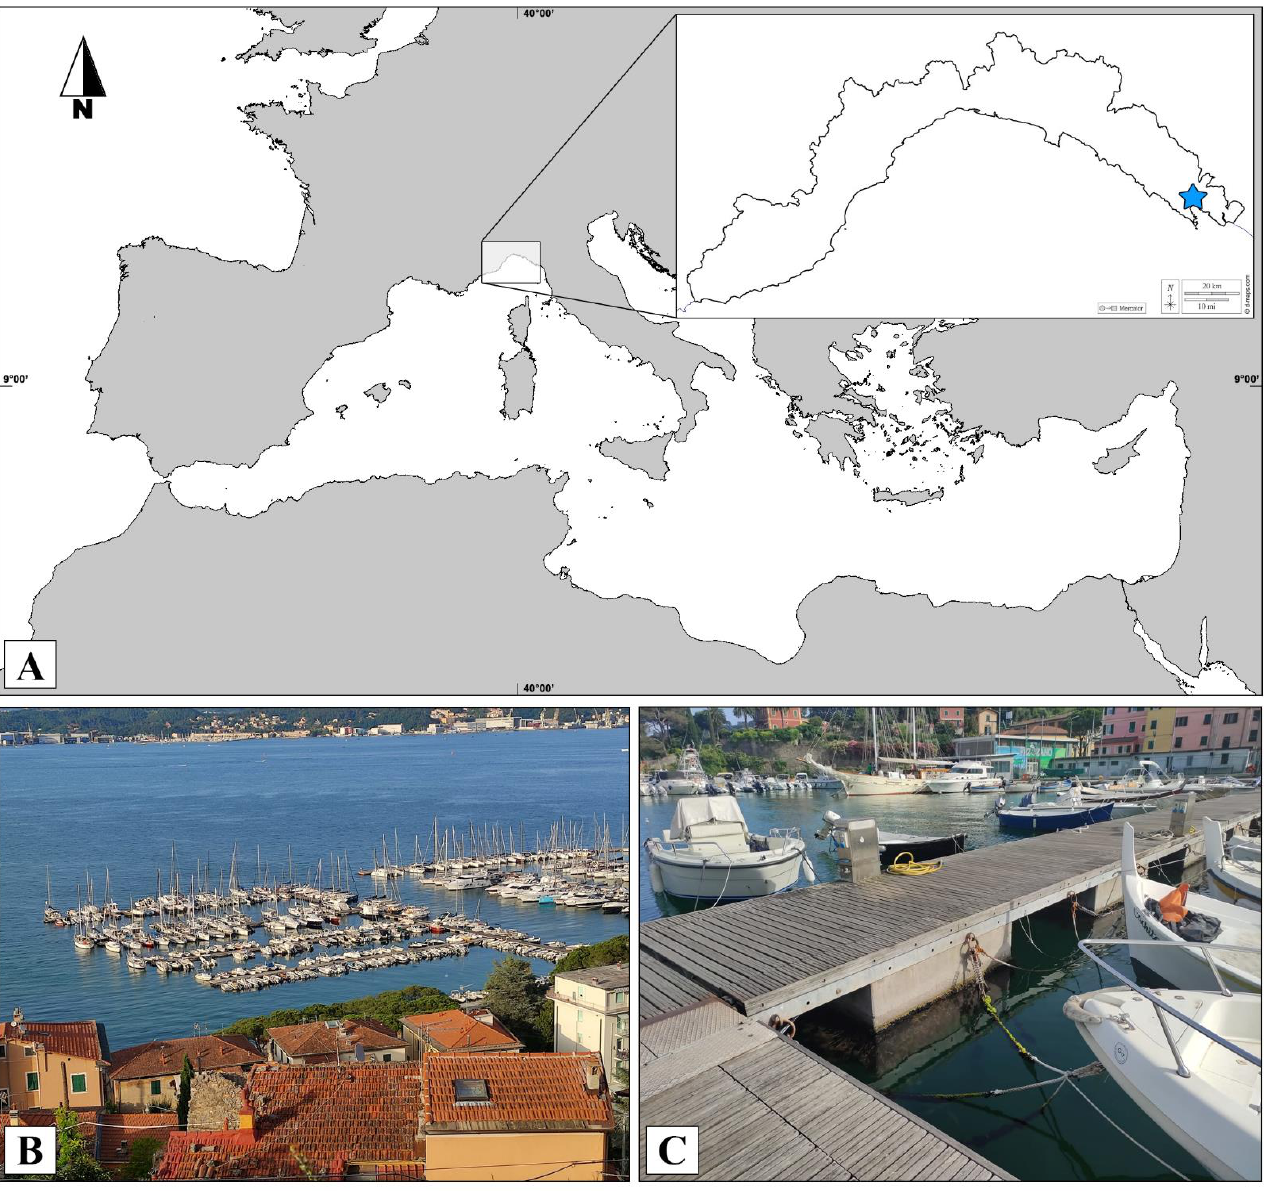
Figure 1. ( A ) Map showing the geographical position of the marina of Fezzano (44°4 ′ 52.2 ″ N, 9°49 ′ 37.8 ″ E) highlighted by the blue star, located in the Gulf of La Spezia in the eastern portion of the Ligurian Sea (north of Mediterranean Sea); ( B ) photograph of the marina of Fezzano; ( C ) floating piers of the marina of Fezzano bordering the monitoring site, characterized by shallow water and a quiet sea surface.